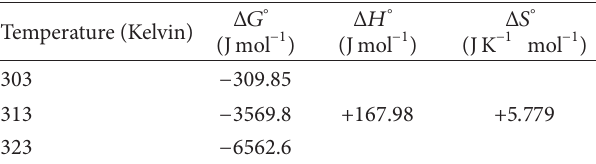
F 9: Pseudo second order kinetics plot for desorption of AO-7 on ANP, 100ppm dye concentration, 303K, pH = 5.